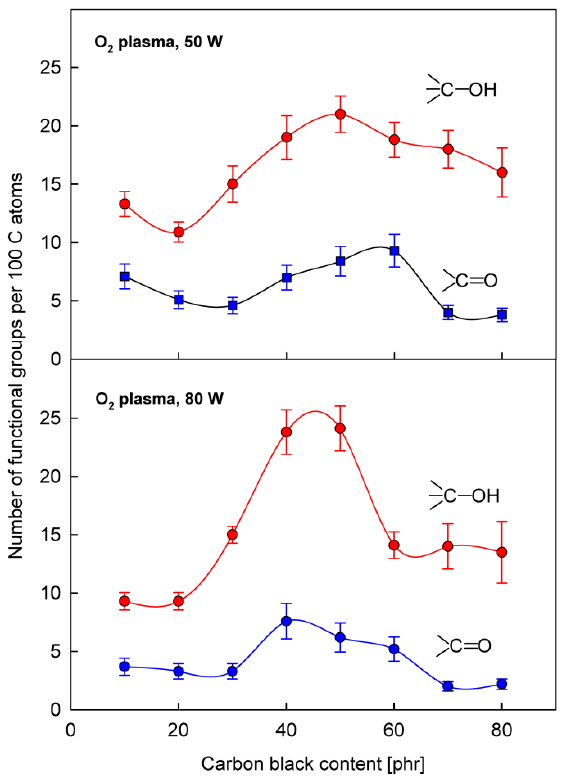
Figure 7. The concentration of functional groups (C − OH, > C = O) on the surface of SBS rubber with various carbon black content, after plasma treatments.